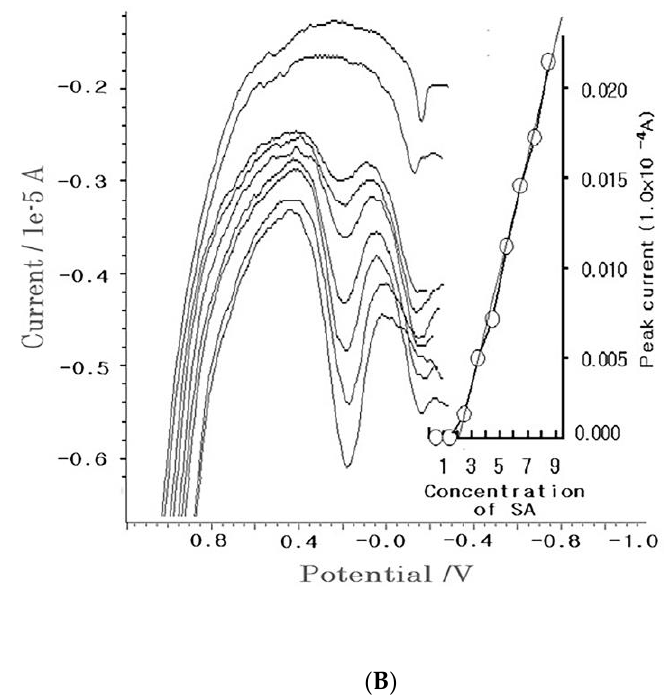
Figure 3. ( A ) Cyclic linear voltammograms for the 0 × 10 − ³, 0.5 × 10 − ³, 1.0 × 10 − ³, 1.5 × 10 − ³, 2.0 × 10 − ³, 2.5 × 10 − ³, 3.0 × 10 − ³, 3.5 × 10 − ³, and 4.0 × 10 − ³ L SA spikes. ( B ) Cathodic stripping voltametric working ranges of the 0.5 × 10 − ³, 1.0 × 10 − ³, 1.5 × 10 − ³, 2.0 × 10 − ³, 2.5 × 10 − ³, 3.0 × 10 − ³, 3.5 × 10 − ³, and 4.0 × 10 − ³ L SA spikes in a 1.0 × 10 − ³ L non-treated blood serum with a pH of 7.0 and 0.02 V SW amplitude, 75 Hz SW frequency, 0.01 V increment potential, −2 .0 V accumulation potential, and 90 s (CV) and 210 s (SW) accumulation times. The optimum conditions were set for the other parameters.